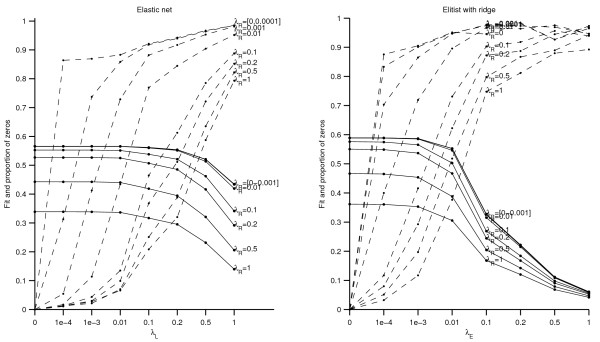
Adding the ridge panel to the (Elitist) lasso. Left panel: Elastic net; Right panel: Elitist lasso with ridge penalty. Fit (full lines) and proportion of zeros (dashed lines) in function of the lasso tuning parameter (left panel) and in function of the Elitist lasso tuning parameter (right panel). The different lines refer to different values of the ridge parameter.